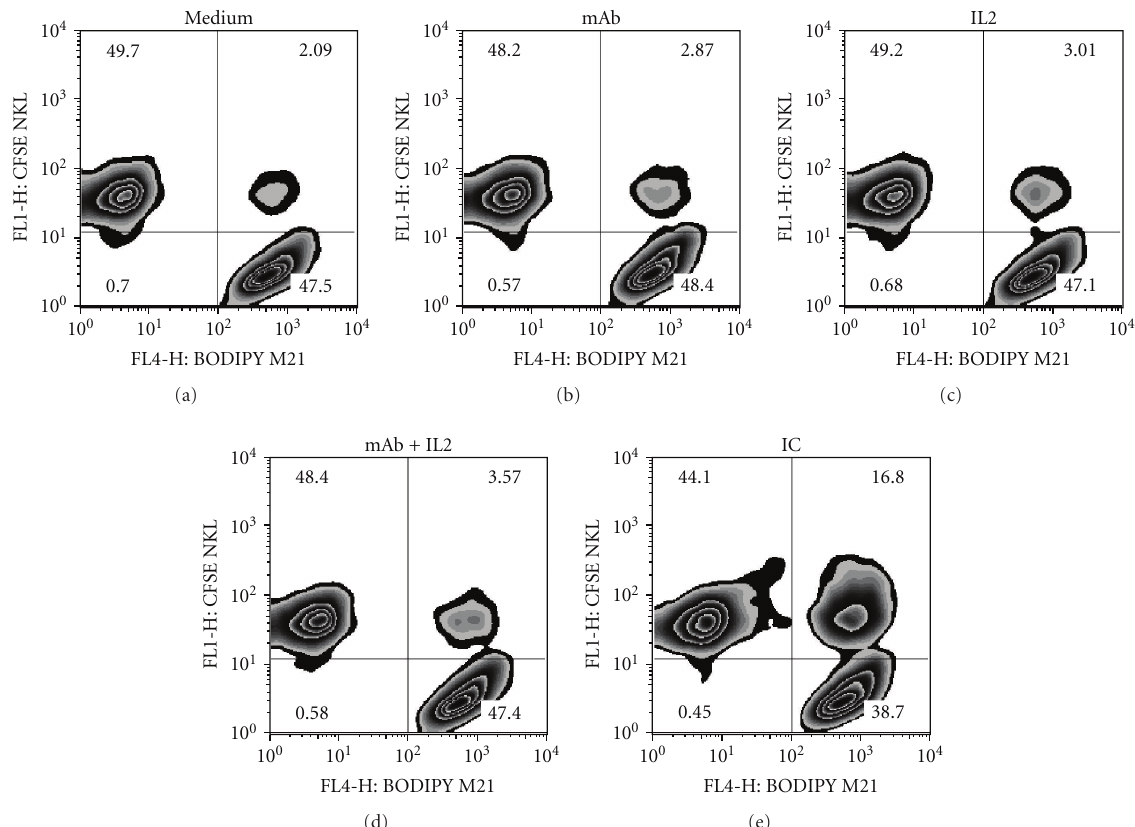
Figure 1: Immunocytokine facilitates adhesion of NK cells to tumor cells. This figure, adapted from Buhtoiarov et al. [36], shows the adhesion of M21 human melanoma tumor cells to NKL human NK cells after coincubation for 30 minutes. Tumor cells were prelabeled with CFSE, and NK cells were prelabeled with BODIPY and coincubated in medium alone, with hu14.18 (mAb) alone, soluble IL2, hu14.18 + soluble IL2, or hu14.18-IL2 immunocytokine (IC). The percentage of cells that had formed conjugates was defined as double positive cells as determined by flow